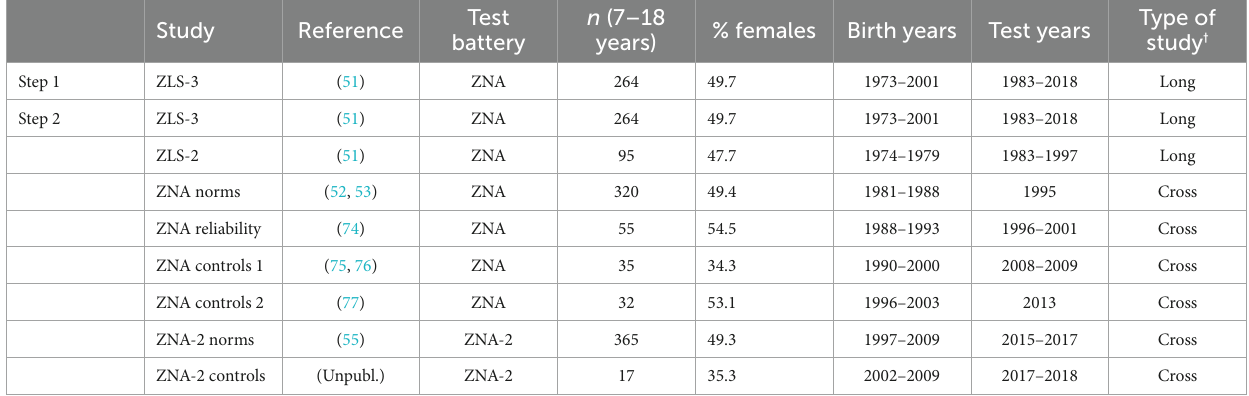
TABLE 1 Characteristics of studies and